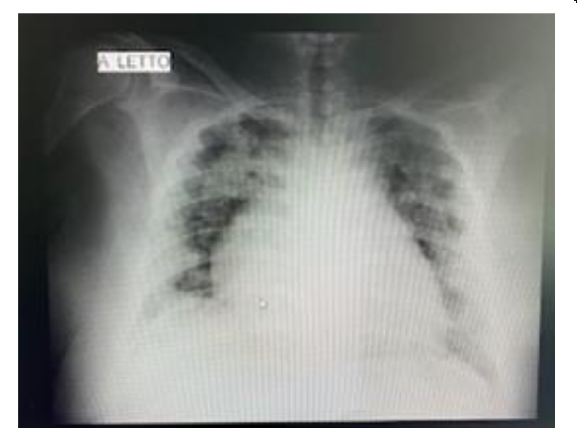
Fig. 1 (abstract A159). See text for description